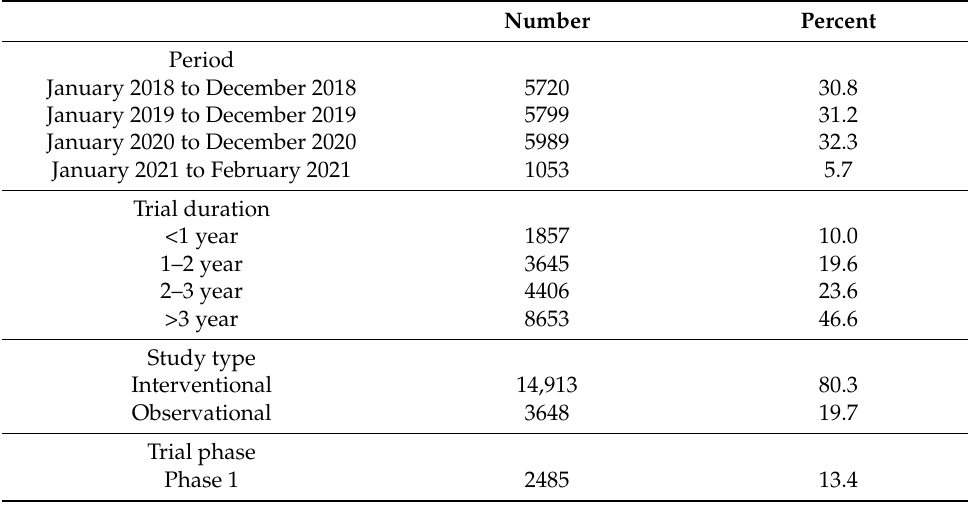
Figure 1. Flow chart of trial selecting oncology trials. Table 1. Basic characteristics of included trials.